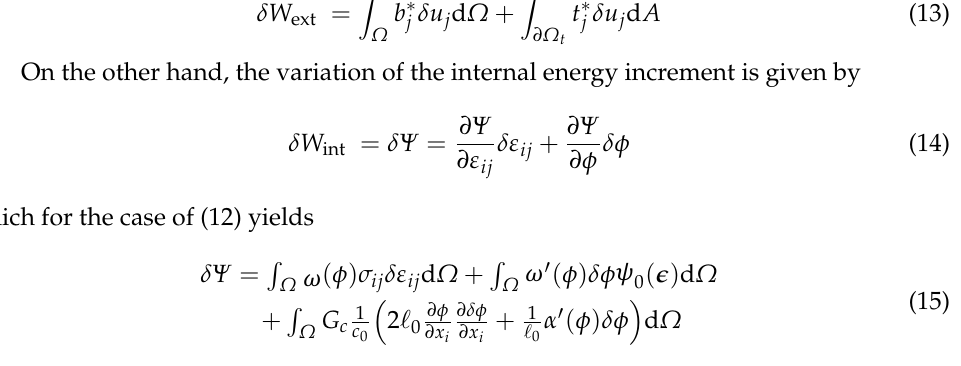
∂𝛺 is denoted as 𝒏 .